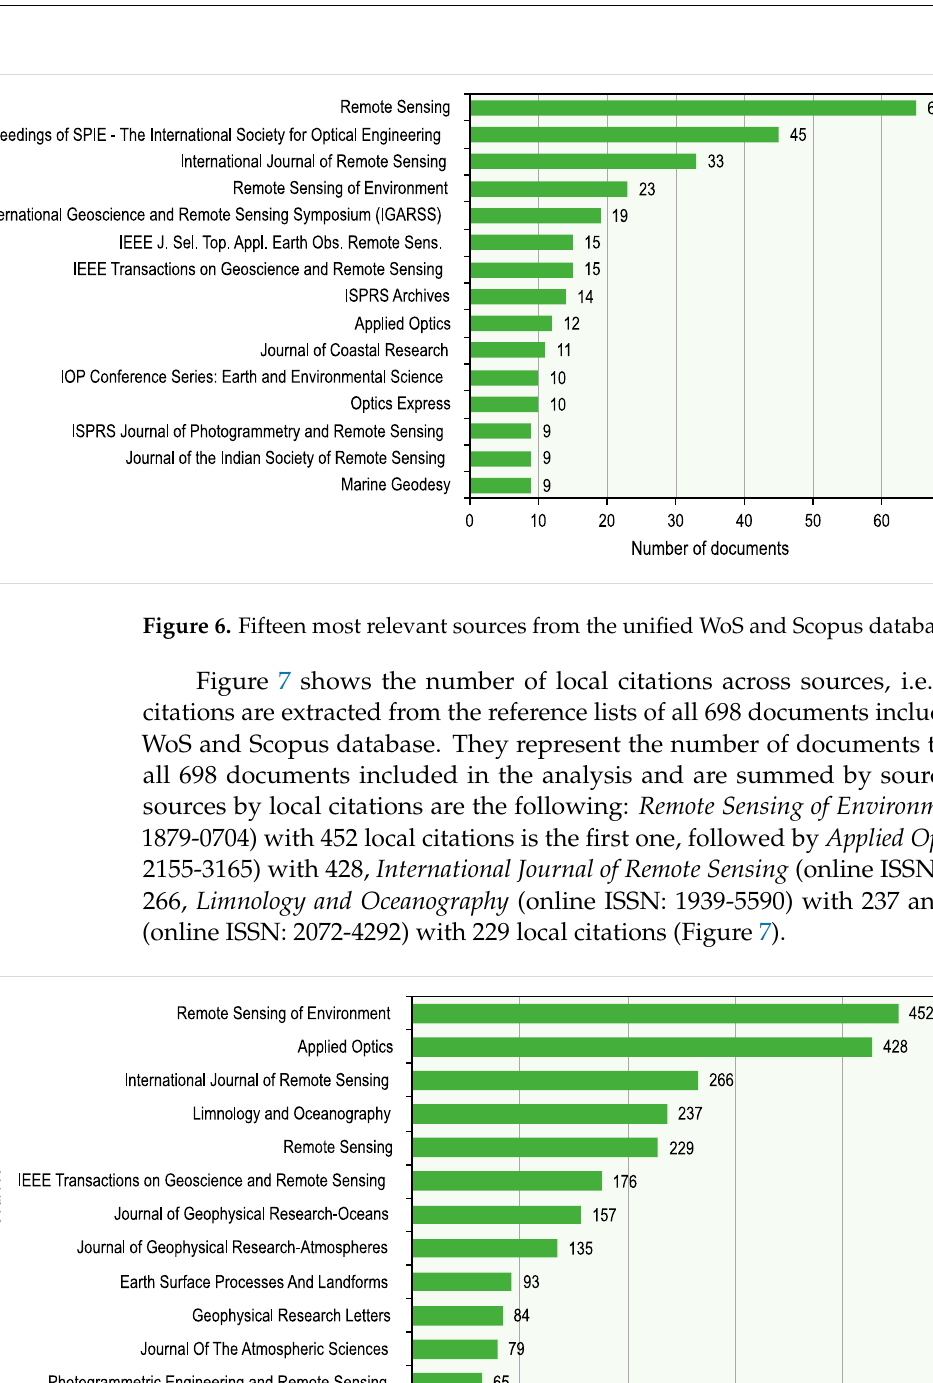
Figure 5. Dynamics of the cumulative number of documents in the top five journals over years.